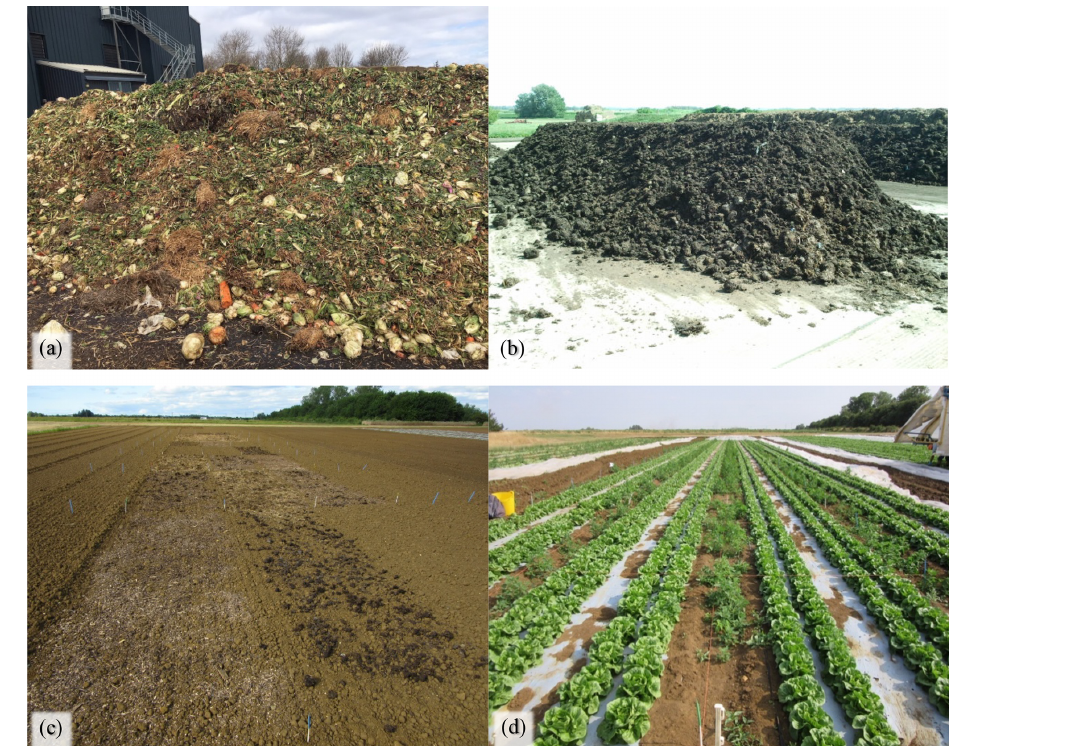
Figure 1. Photographs of the preparation of the mixed compost (a) , the final compost product (b) , the treatments applied to the experimental plots (c) , and the lettuce at the time of harvest (d) . Table 3. Amount (grams per plot) of C, N and other nutrients applied in each treatment. Straw Woodchip Compost Straw–compost Woodchip–compost C 4645 5047